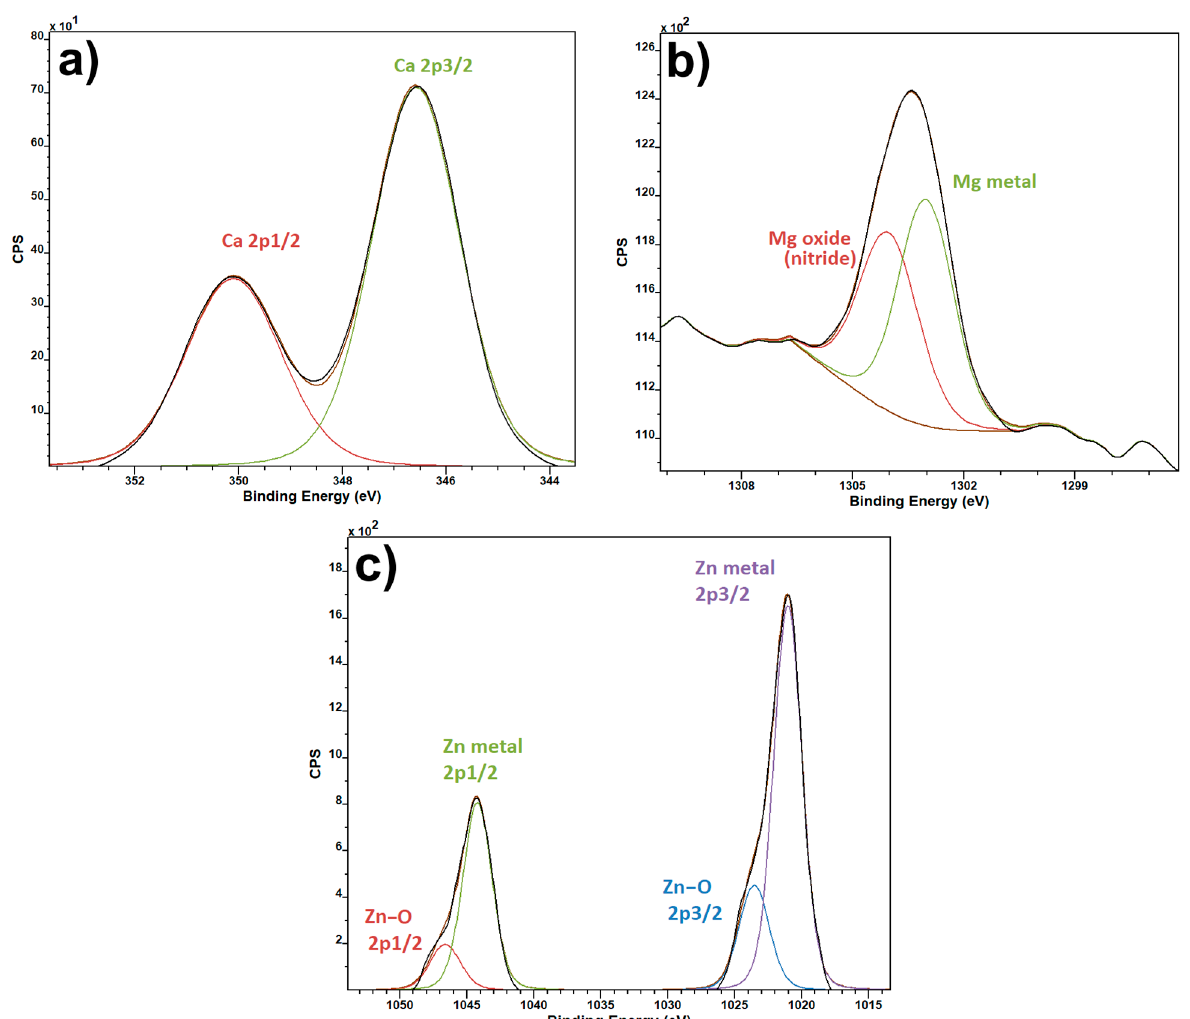
Figure 4. XPS spectra of unique salt elements: Ca2p for PVDF fibers with Ca(NO 3 ) 2 ( a ), Mg1s for PVDF fibers with Mg(NO 3 ) 2 ( b ) and Zn2p for PVDF fibers with Zn(NO 3 ) 2 ( c